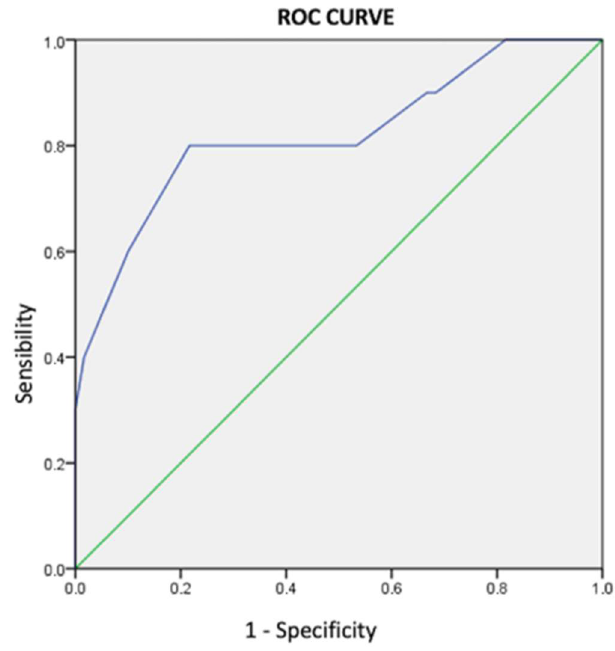
Figure 4. Receiver operating characteristic curve for prediction of echocardiographic response to CRT/CSP by RVs-LVs interval.